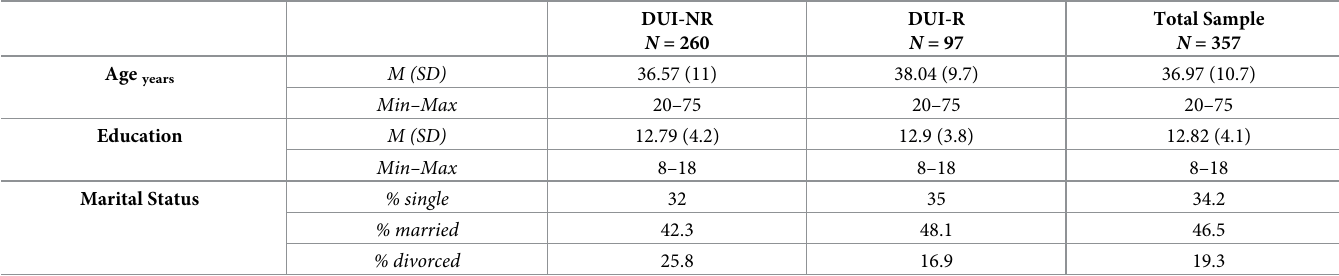
Table 1. Descriptive statistics of the